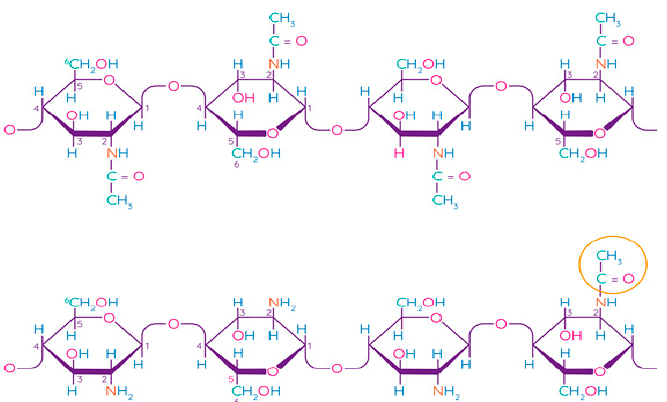
Figure 5. Chemical structure of chitin and chitosan [87]. Reproduced with permission from Rasul,